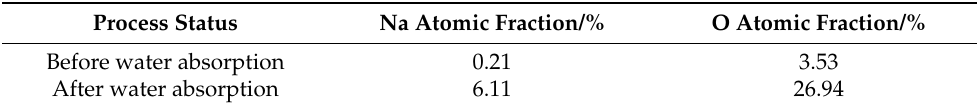
Figure 16. XPS spectrum of Specimen 3 after water absorption: the whole scanning region ( a ); the region of Na ( b ) and the region of O ( c ). Table 3. Na and O atomic fractions before and after water